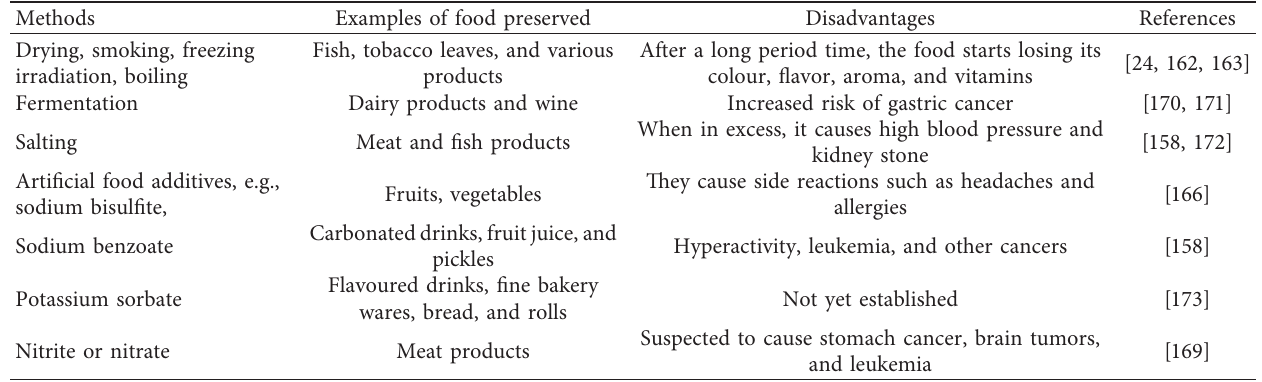
Table 3: Pitfalls of the current methods in food preservation.